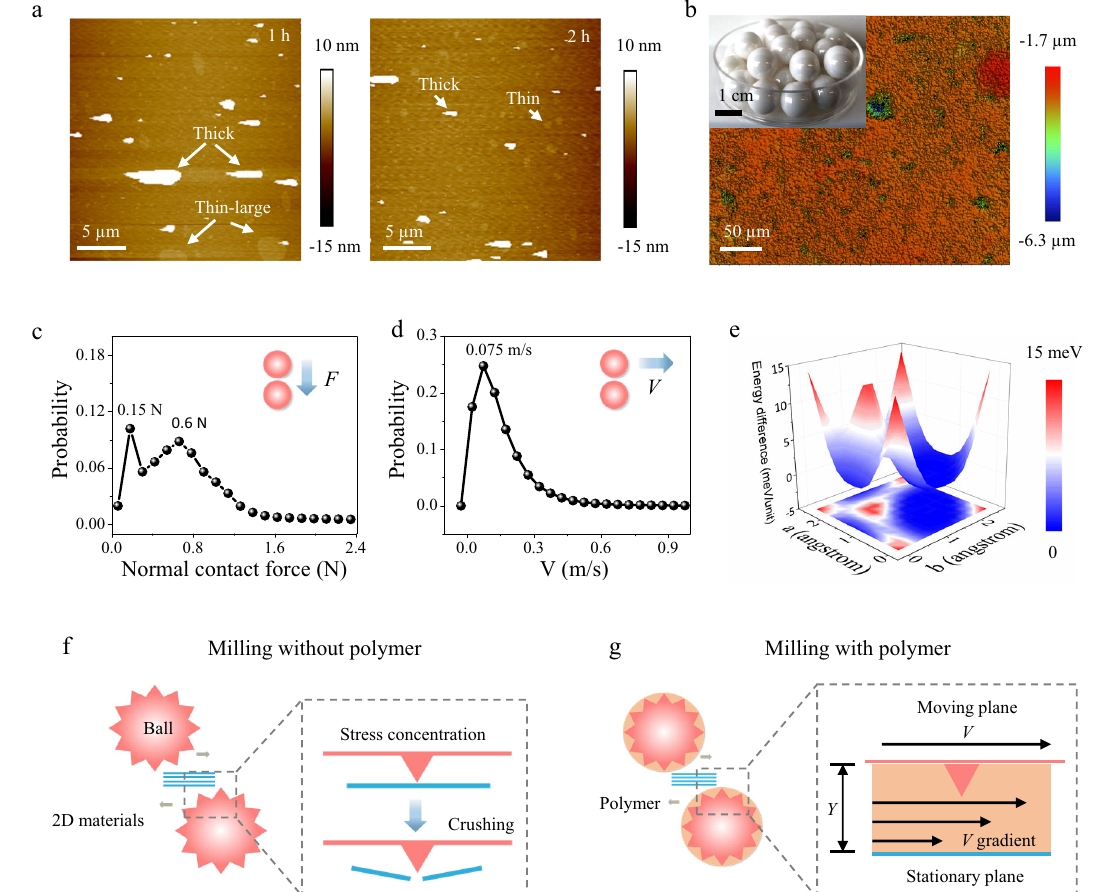
Fig. 3 | Exfoliation mechanism of the sticky exfoliation. a AFM characterization on graphene products obtained after 1 and 2h milling, respectively. b Surface roughnessofthegrindingballs( d =1mm)characterizedbyanopticalpro fi lometer. InsetisaphotographofZrO 2 grindingballs( d =10mm). c Thestatisticalanalysisof the normal compression force, and d the relative velocity of motions between grinding balls during ball milling process obtained by discrete element method (DEM) simulation study. e Density-functional theory (DFT) three-dimensional potentialenergysurfaceforthesliding motionofbilayergraphene.This fi gurewas obtained by statically analyzing DFT energy difference relative to the ground state when sliding a bilayer graphene. x and y indicate the moving displacement along lattice vector direction in graphene unit. z- axis represents energy difference.